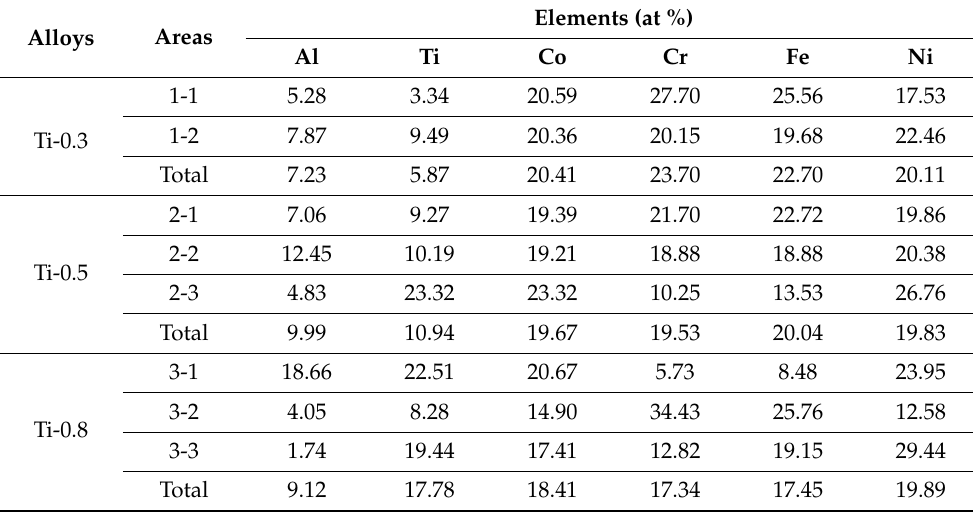
Table 2. EDS results for Al0.5CoCrFeNiTi x